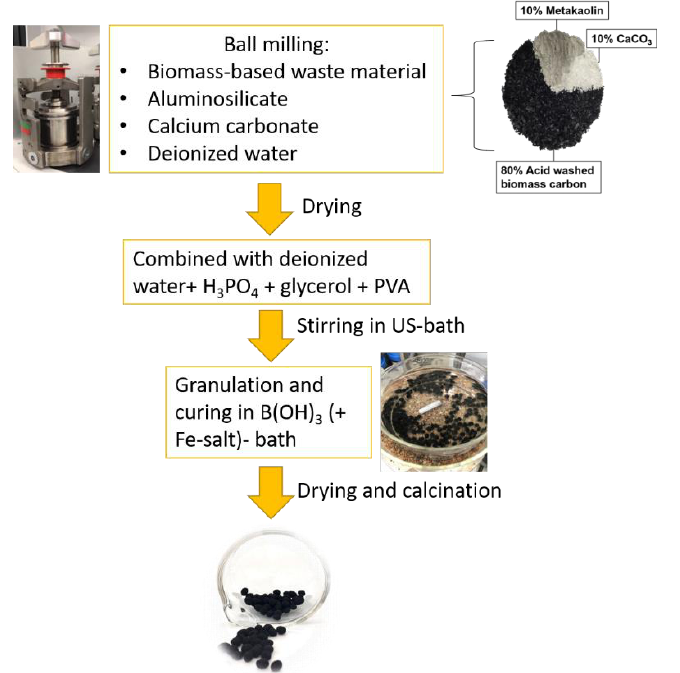
Figure 8. Illustration of the catalysts’ preparation process.